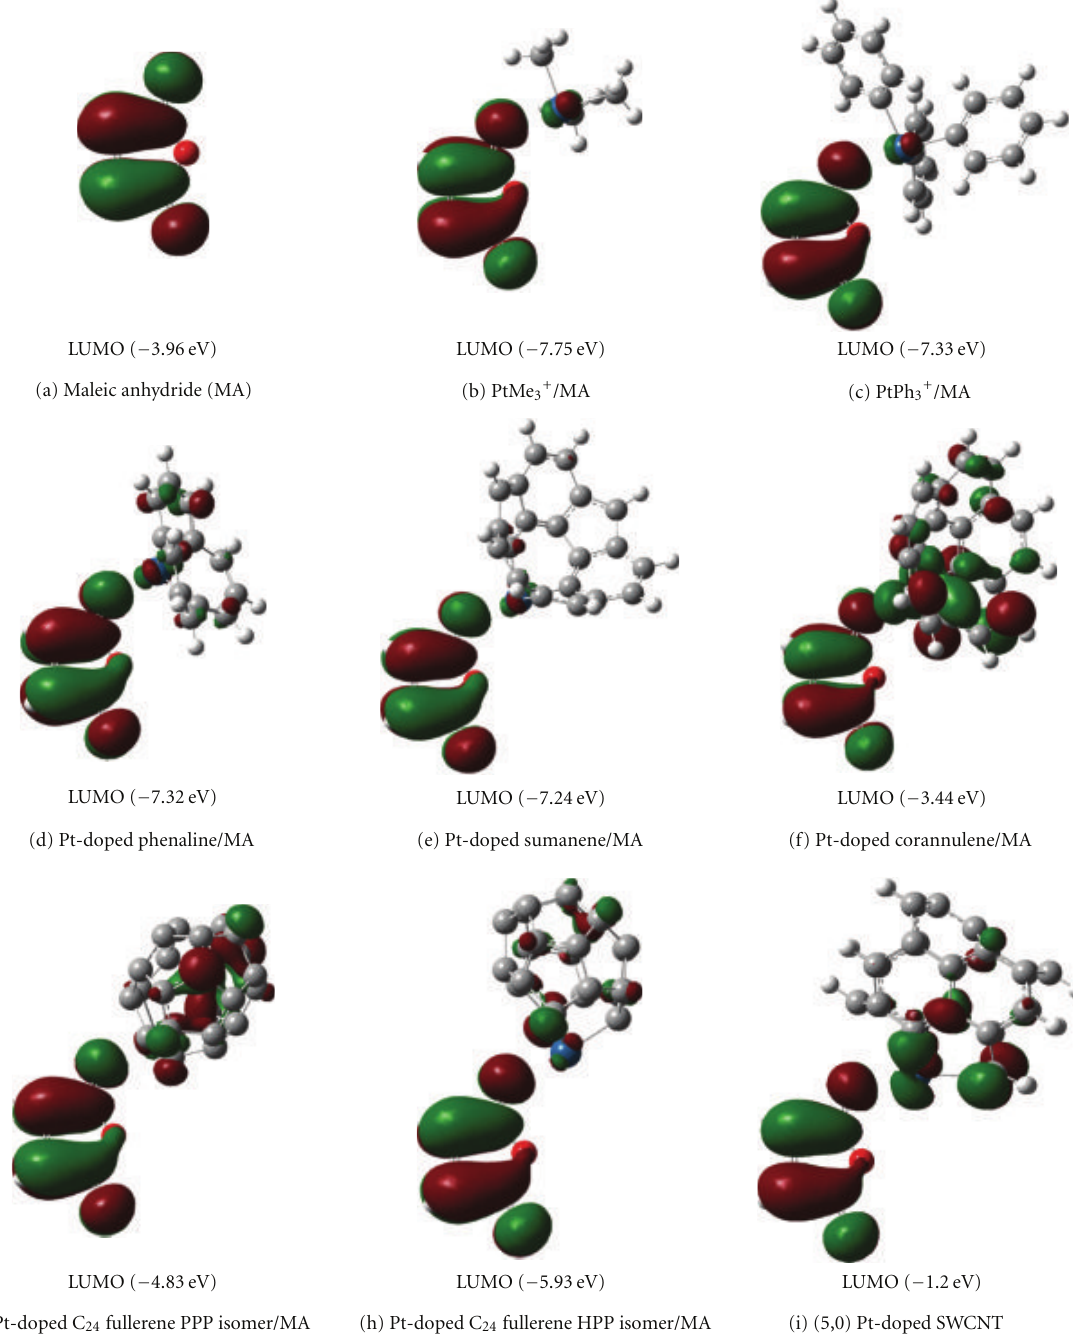
Figure 30: LUMO of Lewis acid/maleic anhydride complexes. Orbital energies are in parentheses [45].